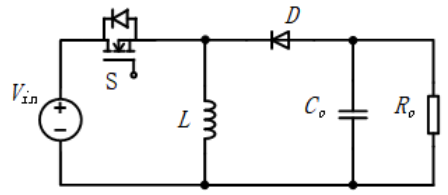
Figure 2. Traditional buck-boost converter.